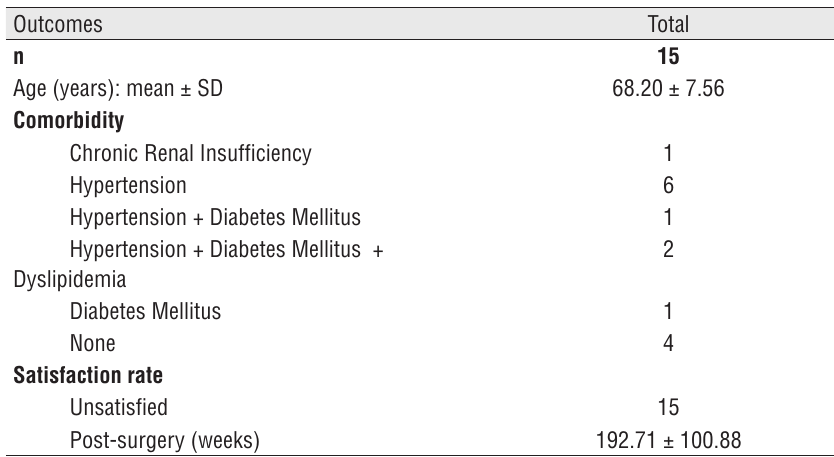
Table 1 - Mean age and medical